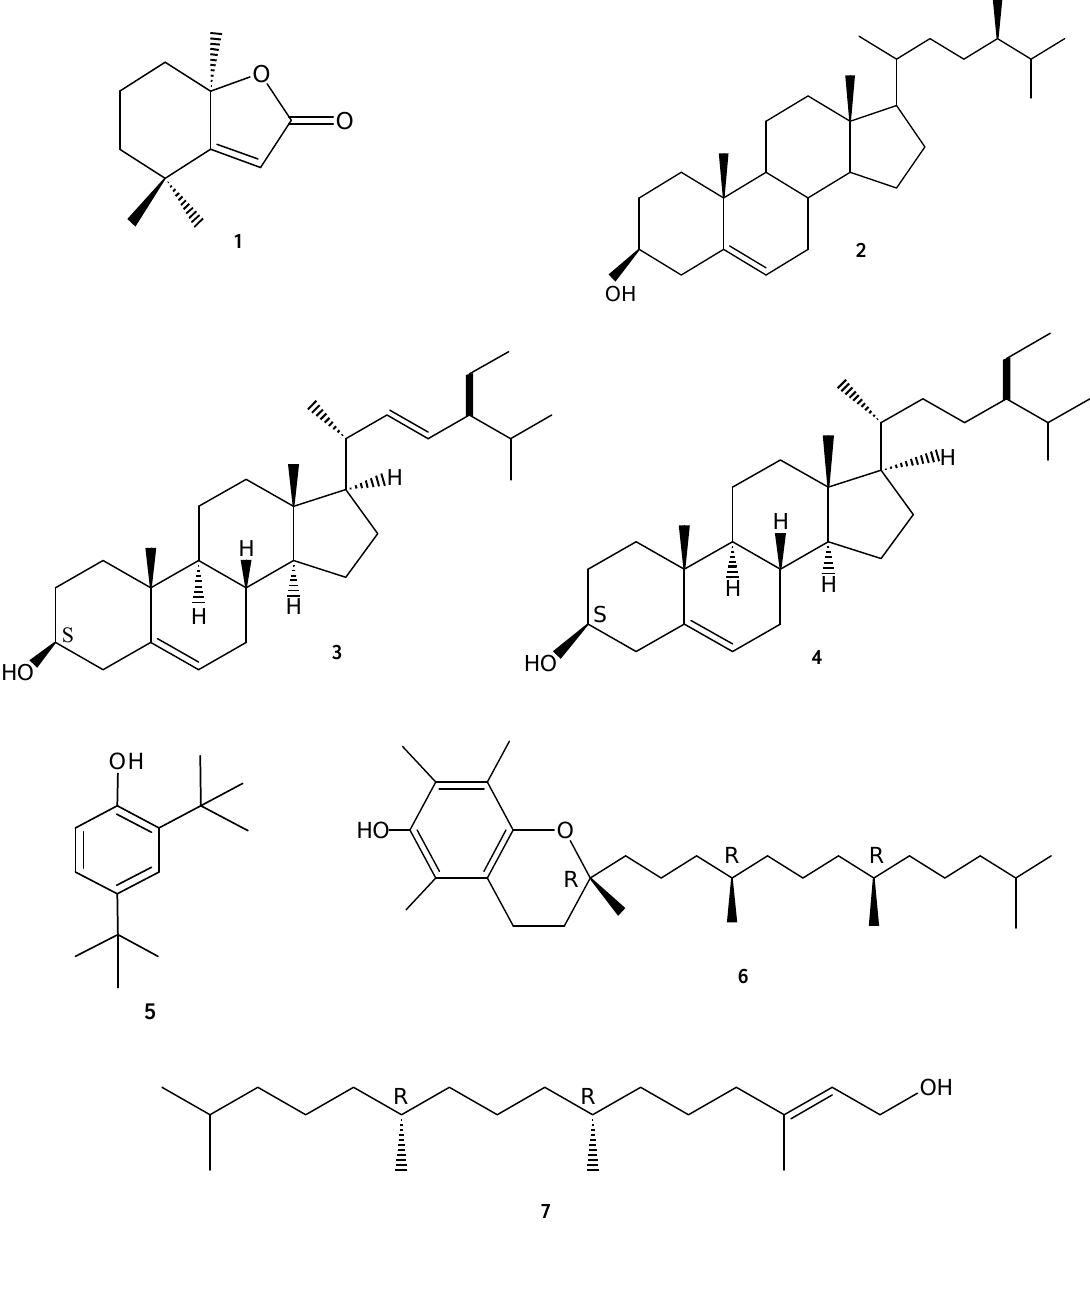
Figure 1. Structures of compounds 1-7